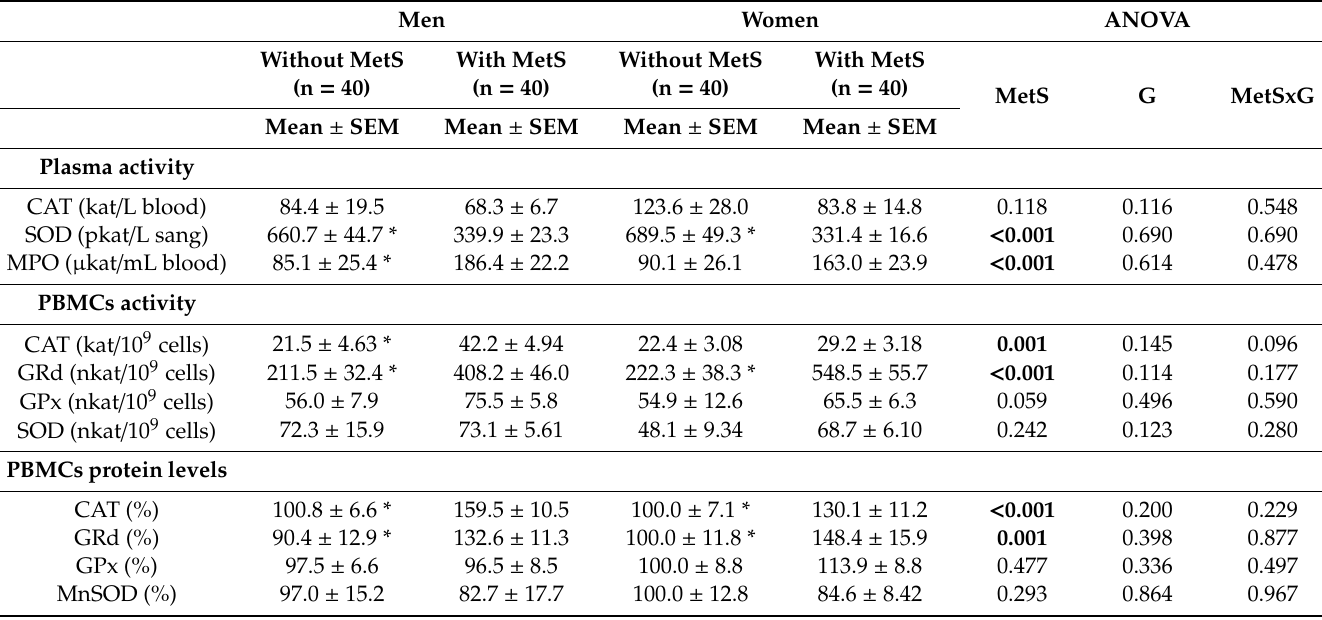
Table 3. Plasma and peripheral blood mononuclear cells (PBMCs) enzymatic activities and protein levels of participants “without Metabolic Syndrome” (n = 80) and “with Metabolic Syndrome” (n = 80) stratified by